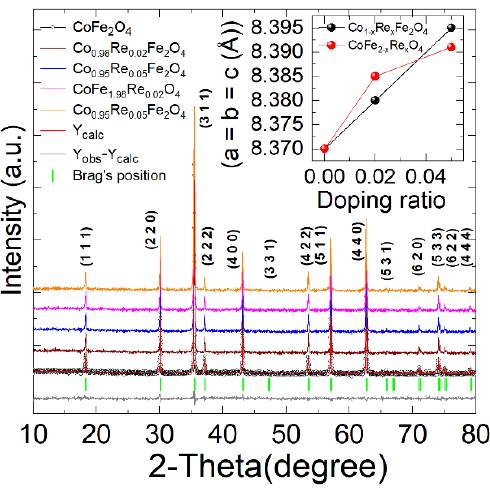
Figure 2. XRD powder pattern of CoFe 2 O 4 , Co 0.98 Re 0.02 Fe 2 O 4 , Co 0.95 Re 0.05 Fe 2 O 4 , CoFe 1.98 Re 0.02 O 4 , and CoFe 1.95 Re 0.05 O 4 nanoparticles. All samples show a pure Fd3m cubic spinel structure. The inserted figure shows the refined cell parameters’ variation with respect to the doping ratio; the cell parameter increases with the increase in the rhenium doping